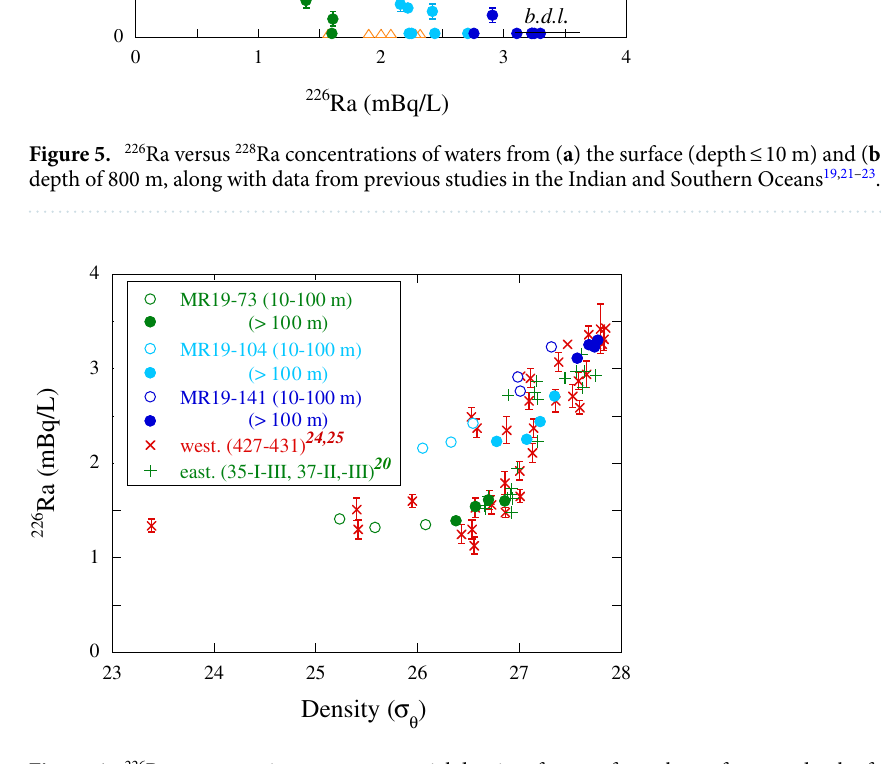
Figure 6. 226 Ra concentrations versus potential density of waters from the surface to a depth of 800 m, along with data from previous studies in the Indian and Southern Oceans 20,24,25